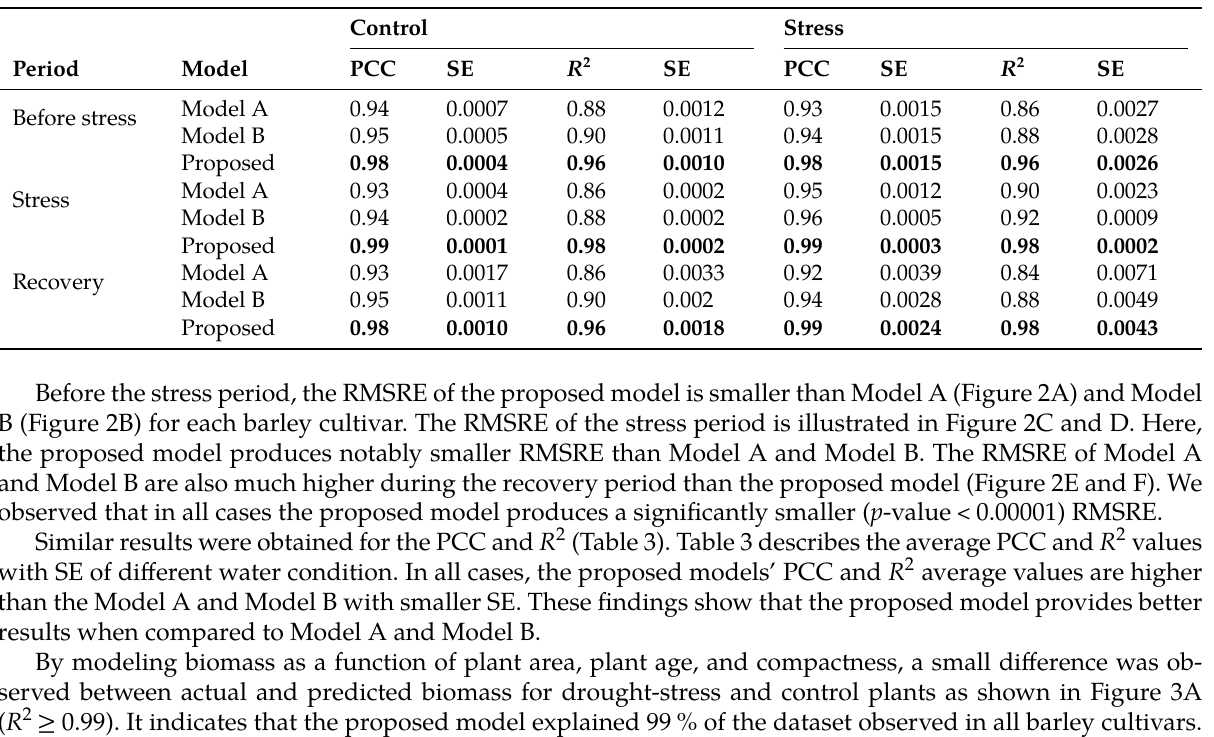
Table 3: The comparison of Model A, Model B and our proposed model using PCC and R 2 values. Control Stress Period Model Before stress